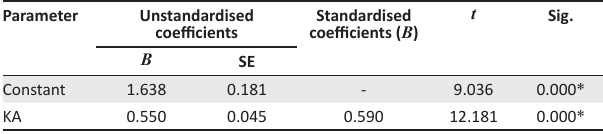
TABLE 4: Parameter estimates for the knowledge acquisition of small and medium enterprises’ absorptive capacity model. Parameter Unstandardised